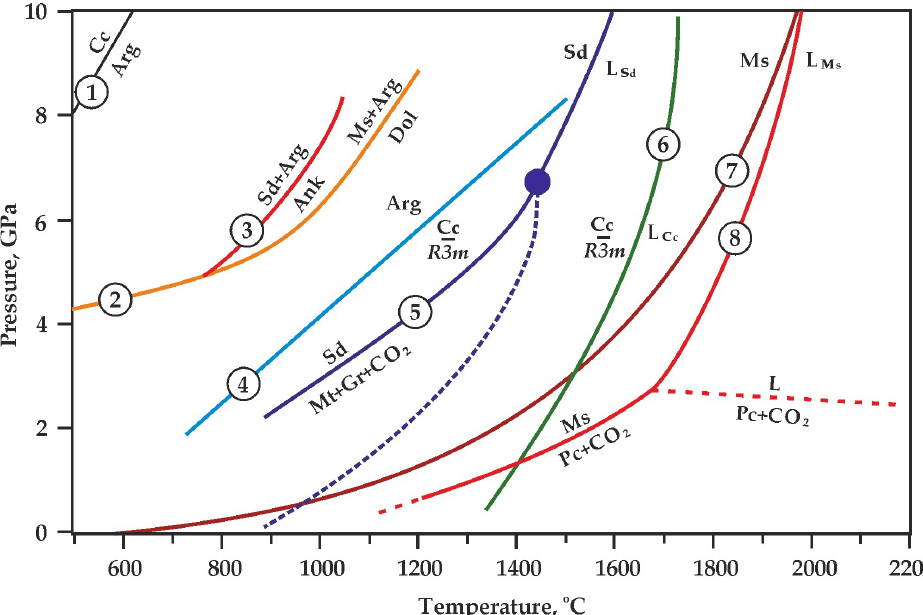
Figure 2. Experimentally determined parameters of melting and decomposition of Mg, Ca, Fe carbonates: